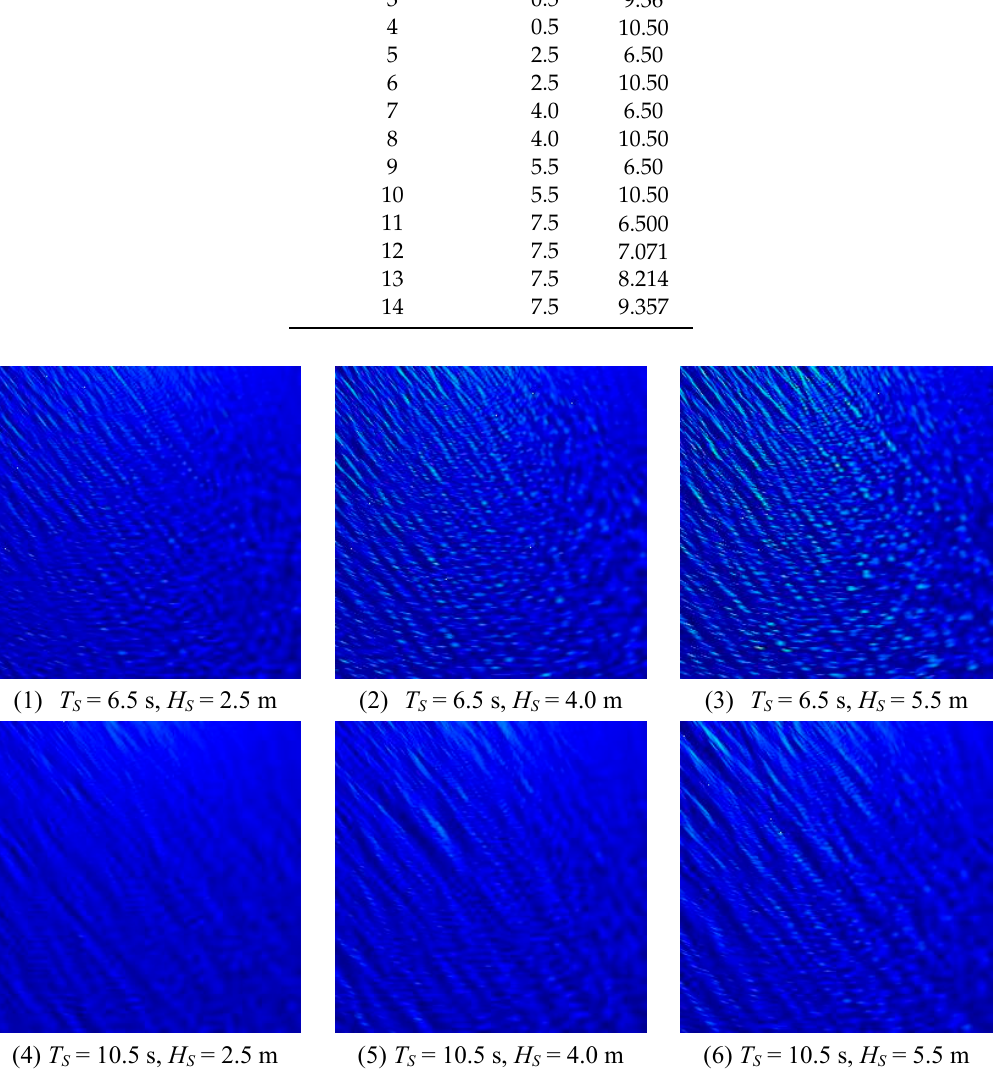
Figure 7. Examples of the test sample images.